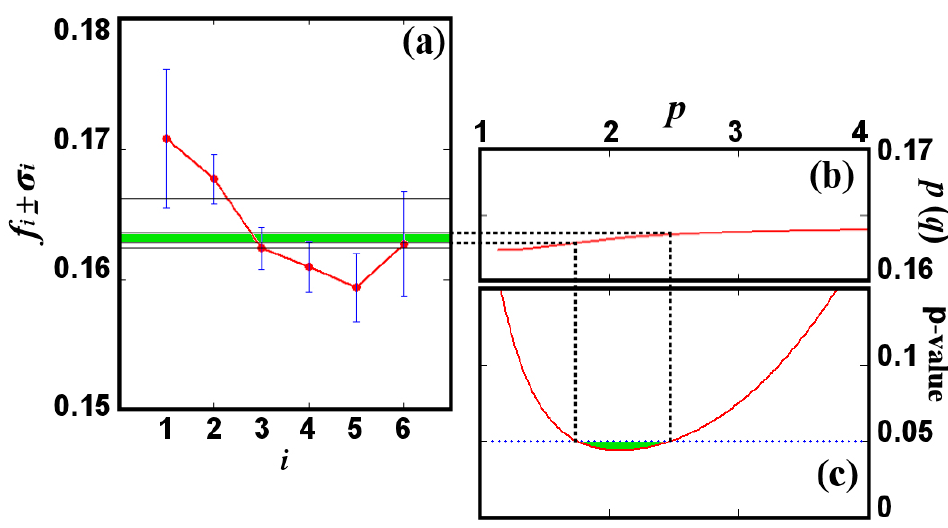
Figure 8. ( a ) The data of Table 1 is co-plotted with four values of p * ( q ) that correspond to q = 1, q → ∞ , and the two norms q 1 ~1.7 and q 2 ~2.5 for which the p -value is equal to 0.05. ( b ) The diagram of p * ( q ). ( c )